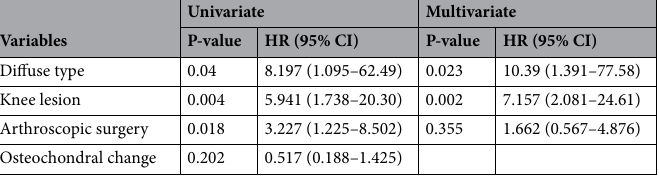
Table 2. Cox regression analysis of Local recurrence free survival. HR hazard ratio, CI confidence interval.